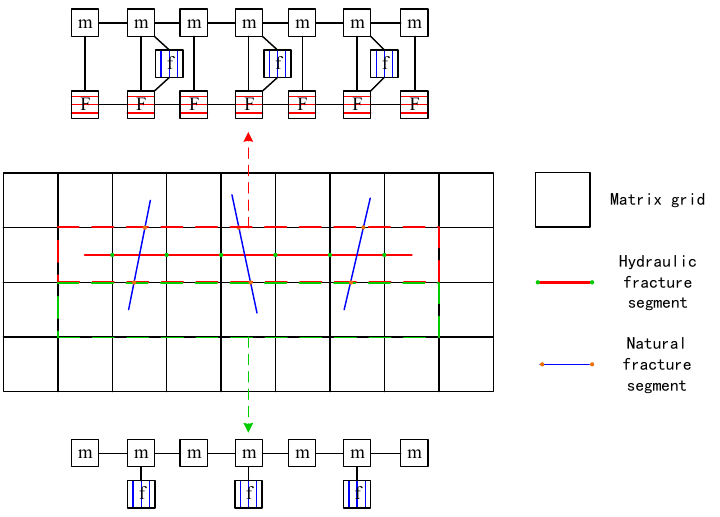
Figure 1. Schematic of fractured-shale-reservoir discretization: m = matrix; F = hydraulic fracture; f = natural fracture.